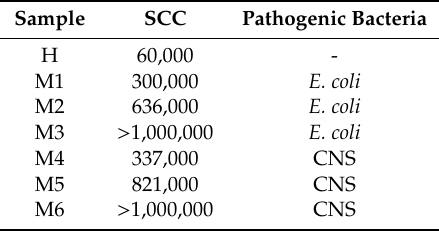
Table 1. Somatic cell count (SCC) values and identified pathogen within milk samples. Sample